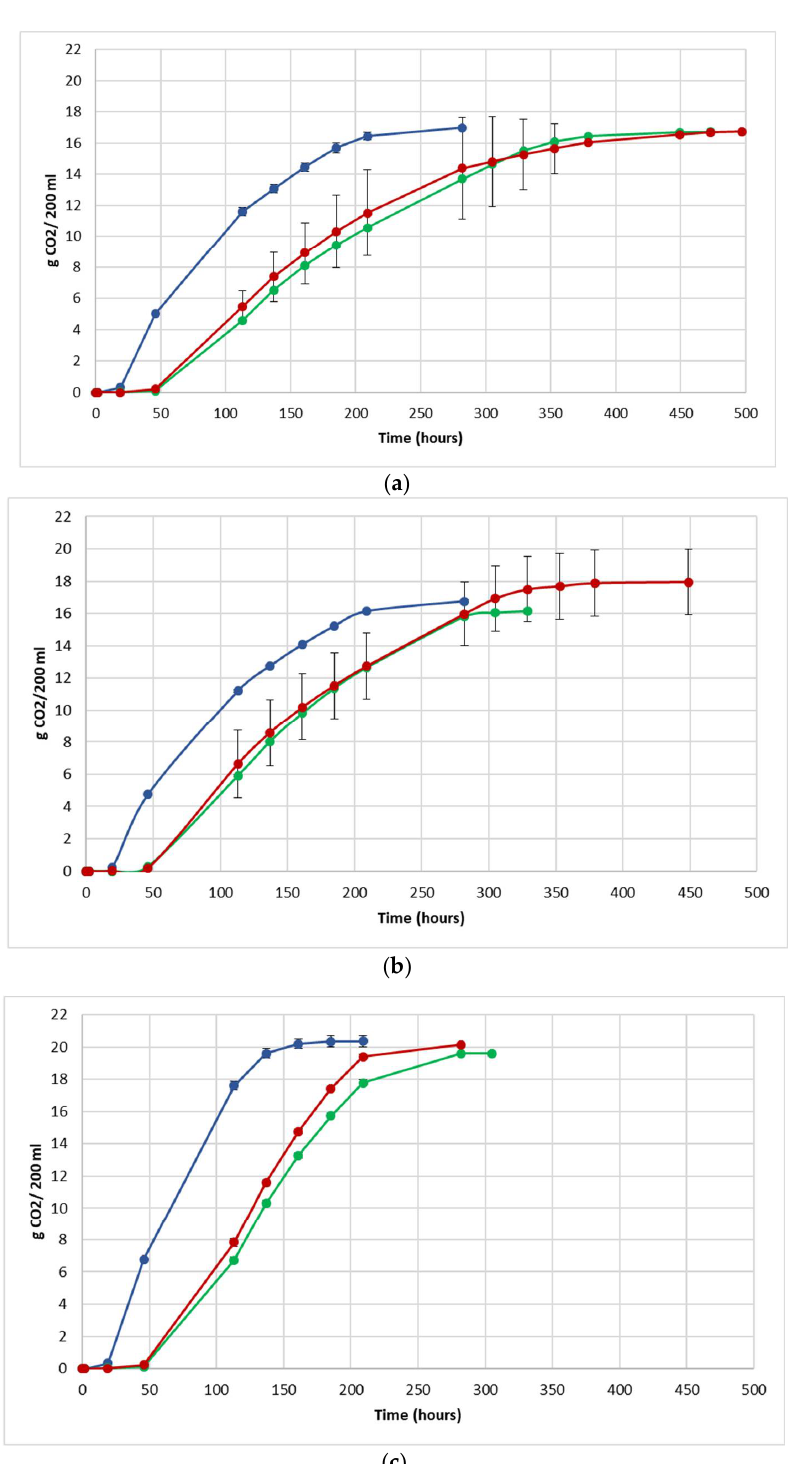
Figure 3. Fermentation kinetics (CO 2 released/time) in natural grape must. ( a ) JUICE, ( b ) CRYO and ( c ) JUICE + MARC. NT: untreated control (blue), LCC: low cell concentration (green), HCC: high cell concentration (red). Data are expressed as the average of three replicates ± standard deviations.